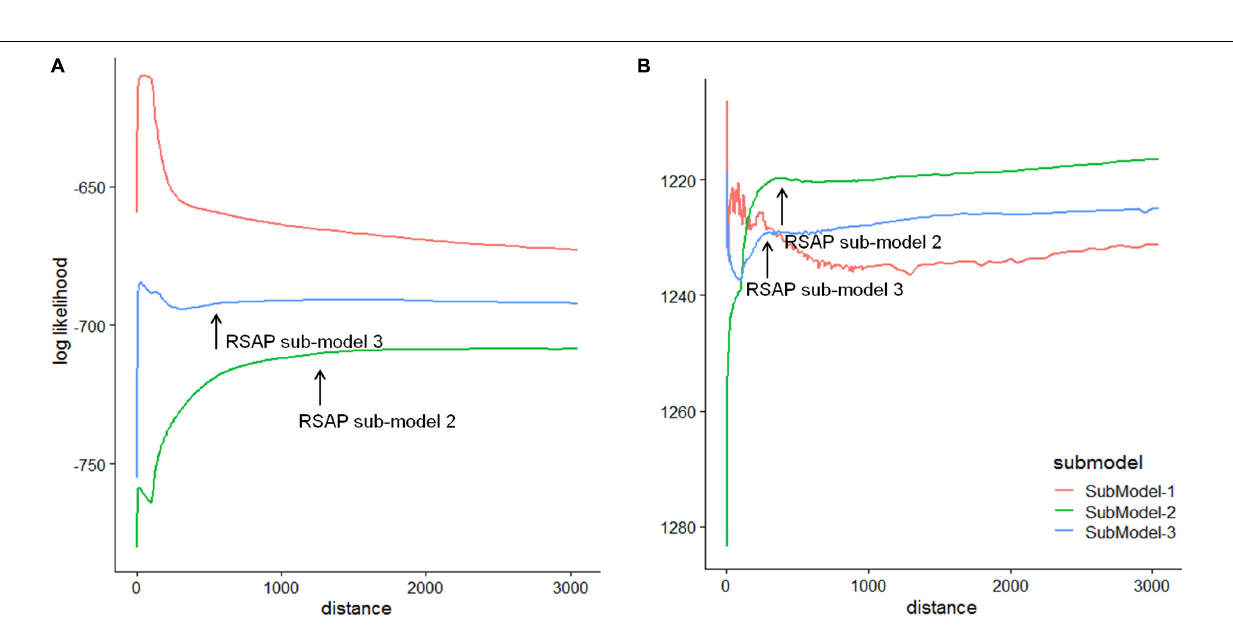
FIGURE 6 | Plots of the log-likelihood against distance from the sampling point using three ERV sub-models for (A) Chukotka and (B) Yakutia, based on pollen data from moss/soil samples and vegetation data within a 3000 m radius.